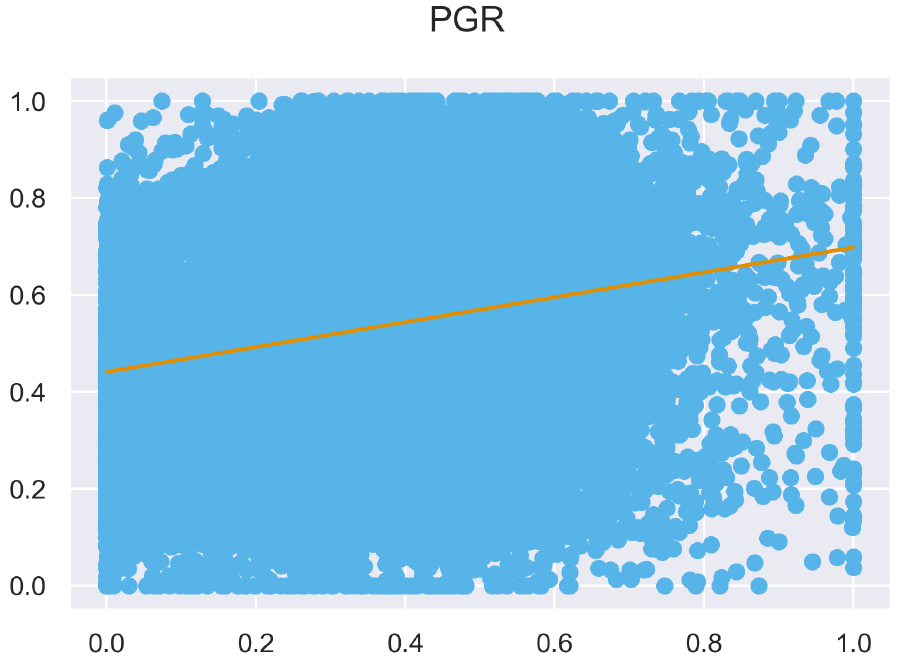
Figure A12. ULS and TLS PGR regression at 0.5 m grid